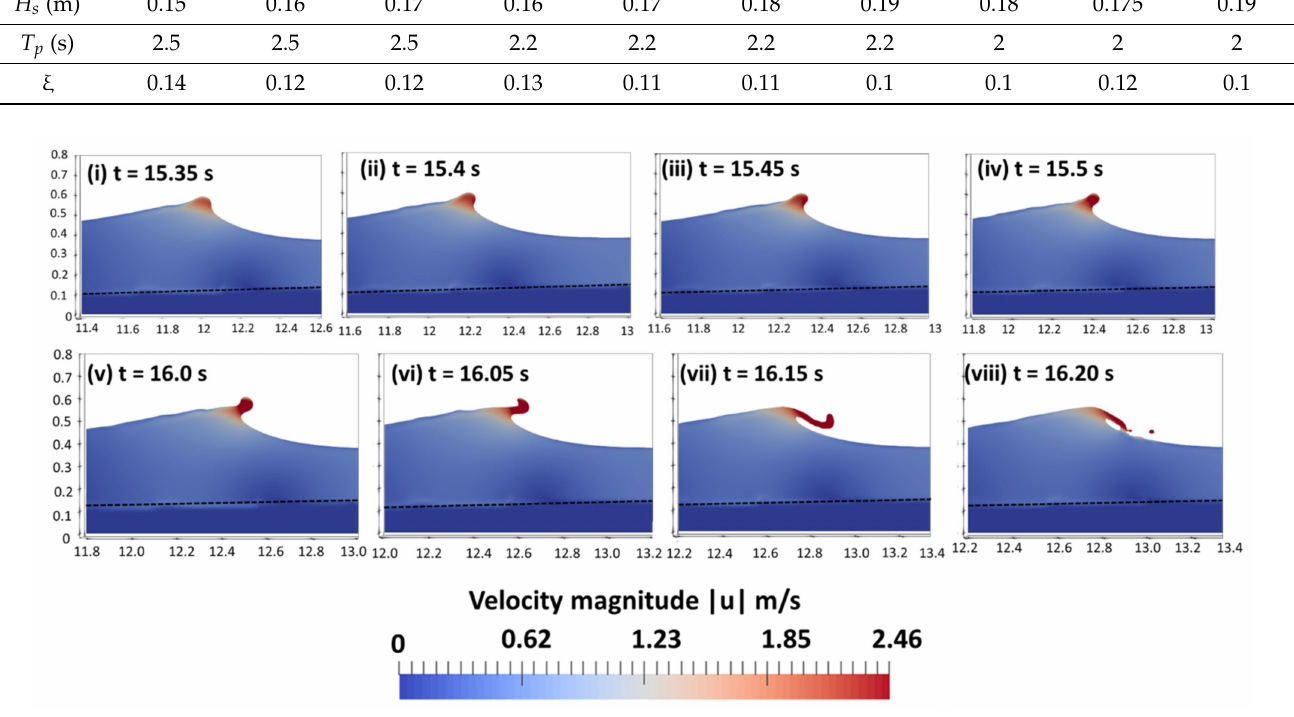
Figure 6. Velocity variation at different time steps showing the stages of breaking ( i ) t = 15.75 s, ( ii ) t = 16.05 s, ( iii ) t = 16.15 s, ( iv ) t = 16.30 s ( v ) t = 16.40 s ( vi ) t = 16.45 s ( vii ) t = 16.50 s and ( viii ) t = 16.60 s (NWT dimensions in m).